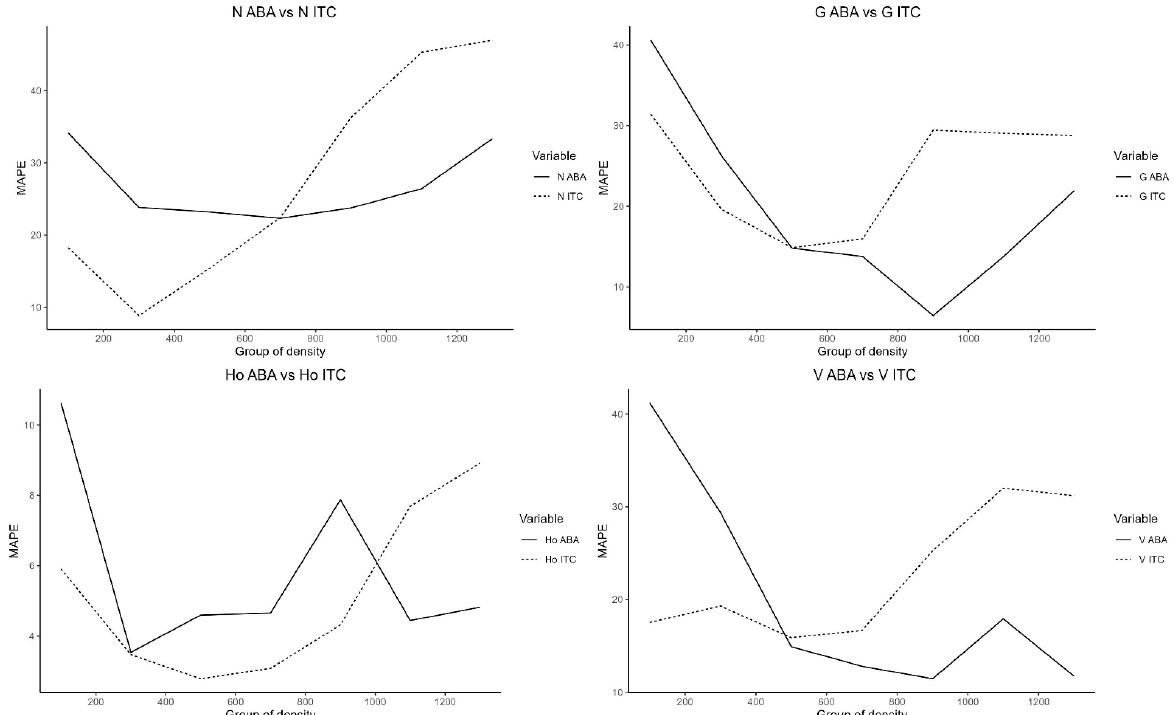
Figure 4. Distribution of the mean of the absolute value of the residuals (MAPE,%) in the estimation of the forest inventory attributes of Pinus radiata stands in Ñuble Region (South, Chile) using the Area-Based Approach (ABA) and Individual Tree Crown (ITC) models (see Table 2, n = 48 plots) as a function of plot density in intervals of 200 trees ha − 1 . Density (N, trees ha − 1 ), Assman´s dominant height (Ho, m), Basal area (G, m 2 ha − 1 ), Volume (V, m 3 ha − 1 ). Table 4. Distribution of forest inventory attributes of Pinus radiata stands in the Ñuble Region (South, Chile) as a function of plot density in intervals of 200 trees ha − 1 . Density (N, trees ha − 1 ), Assman ´ s